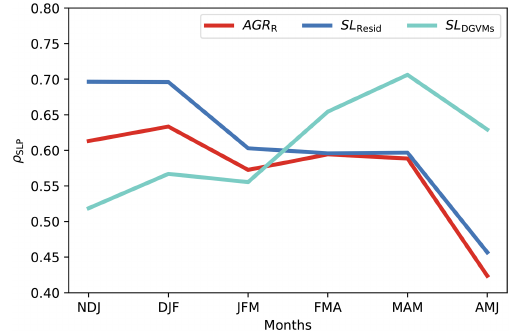
Figure A2. ρ SLP of AGR R , SL Resid , and SL DGVMs under dif- ferent seasonal SLP (with different month combination) by ridge regression leave-one-out cross-validation in the period of 1959– 2017. Each combination represents NDJ (November, December, and January), DJF (December, January, and February), JFM (Jan- uary, February, and March), MAM (March, April, and May), and AMJ (April, May, and